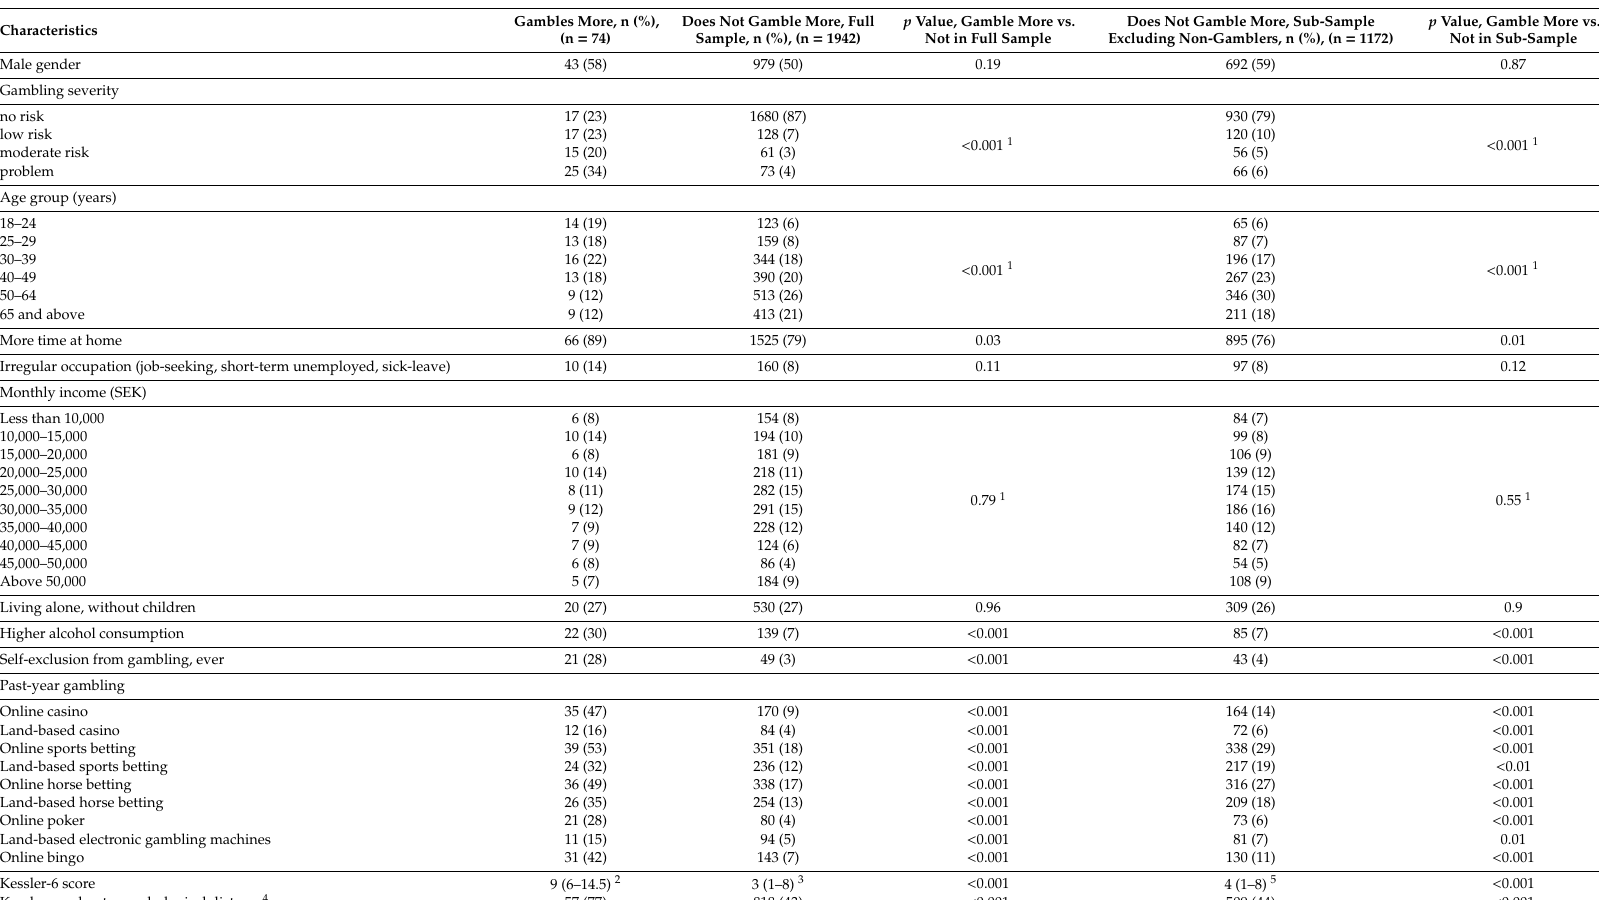
Table 2. Comparison of individuals reporting increased gambling, compared to all those reporting either unchanged gambling, decreased gambling or no gambling (full data, N = 2016), and compared to those reporting unchanged or decreased gambling (non-gamblers excluded, total N = 1246). Comparisons made with chi-square analysis for categorical data, and Mann-Whitney U test for continuous